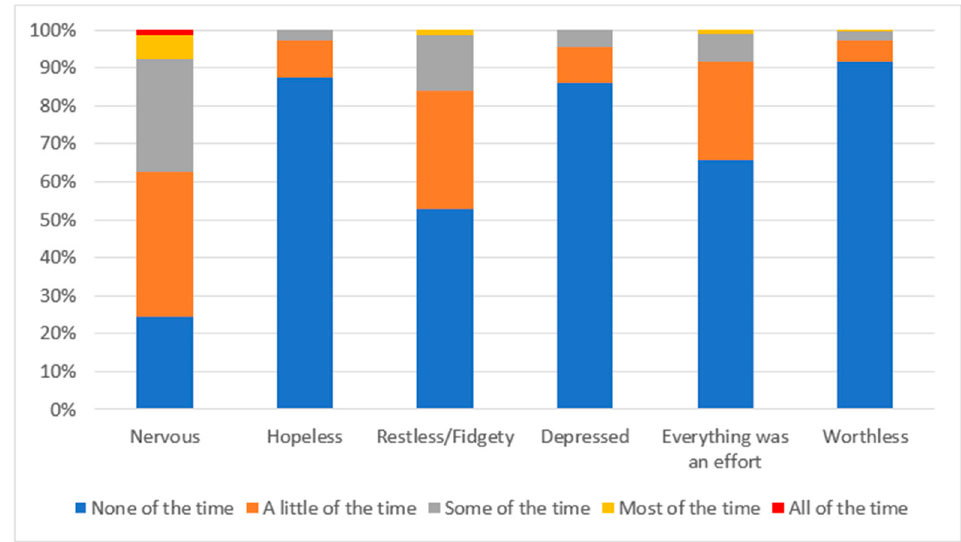
Figure 1. Profile of six-item Kessler Psychological Distress Scale (K6) responses.